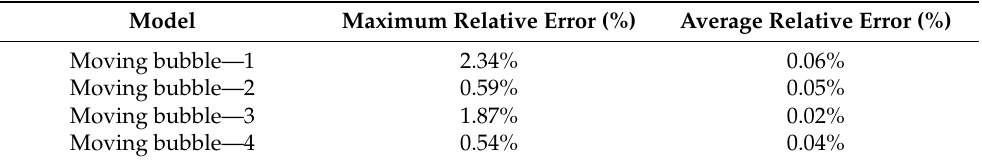
Table 3. Electric potentials on nodes by using CFEM and XFEM. Model